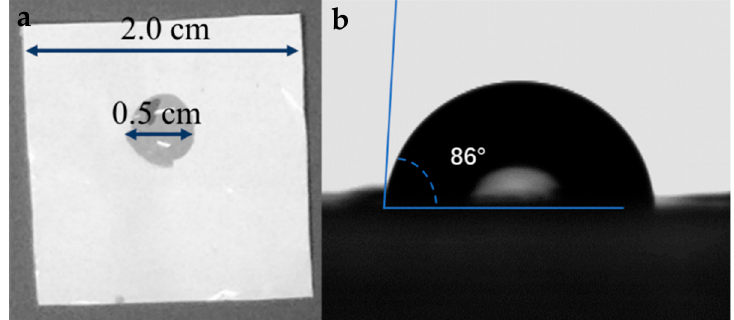
Figure 4. The wettability of Celgard2325: ( a ) the wetted area of an electrolyte and ( b ) the contact angles of water.